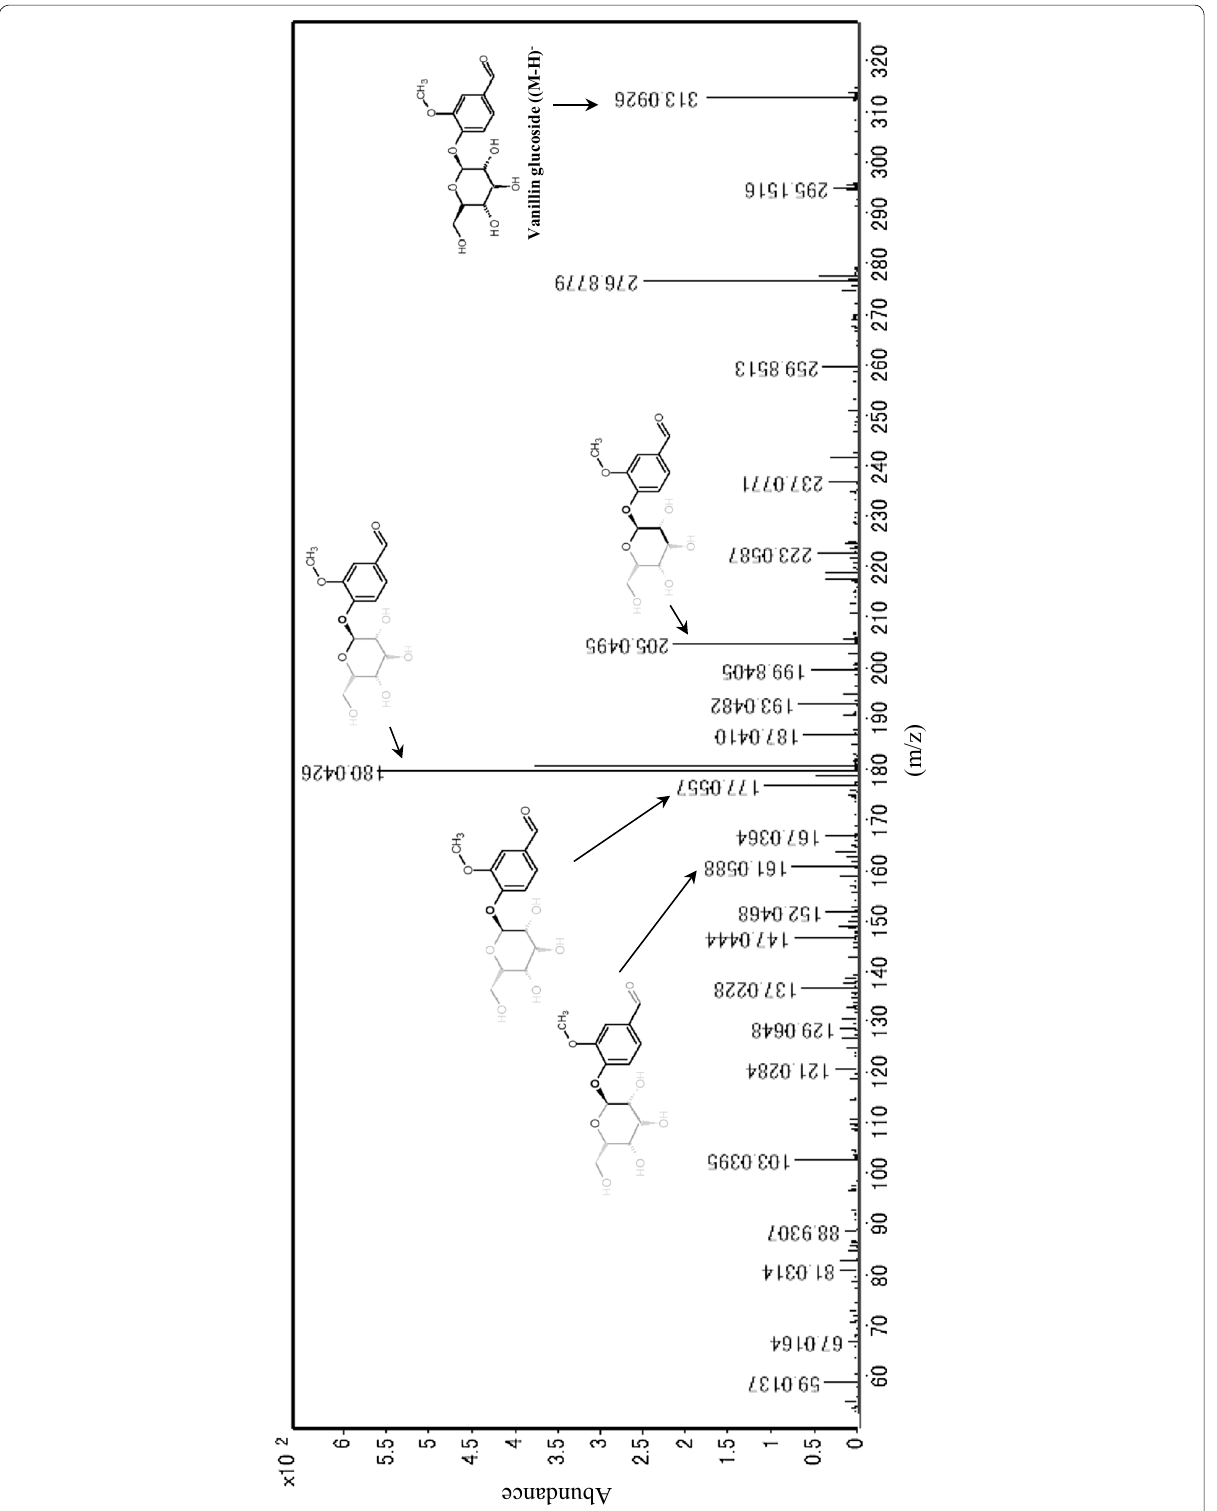
Fig. 3 The mass spectrometry of vanillin glucoside produced during the phenolic biotransformation of Aspergillus luchuensis. The HRESI-mass spec- trometry of vanillin glucoside was measured by LC/MS/MS. The accurate molecular formula of vanillin glucoside was determined to be C 14 H 18 O 8 based on the mass 313.0927 (M-H) − , 313.0926, calcd. for C 14 H 18 O 8 . The other production ions derived from the vanillin ( m/z : 161.0588, 177.0557, 180.0426 and 205.0495) were also detected which were structurally